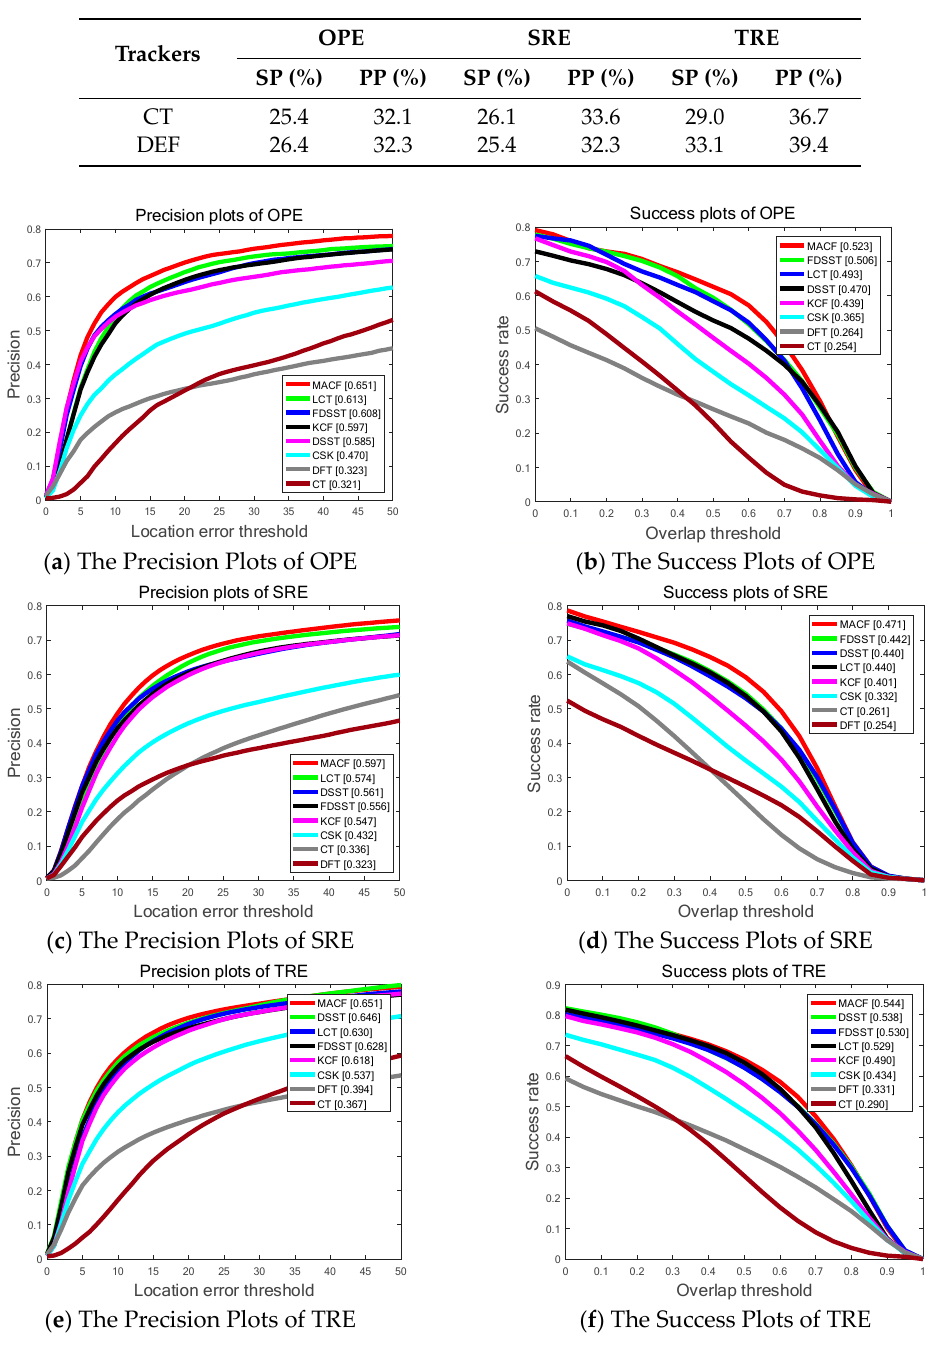
Figure 6. The Success Plots (SP) and Precision Plots (PP) of One Pass Evaluation (OPE), Temporal Robustness Evaluation (TRE) and Spatial Robustness Evaluation (SRE) using by Overlap Threshold (OT) and Location Error Threshold (LET) comparing MACF with the state-of-the-art trackers on OTB-50 benchmark. The ranks for the top 8 trackers are reported with the Area Under the Curve (AUC) marked in brackets.